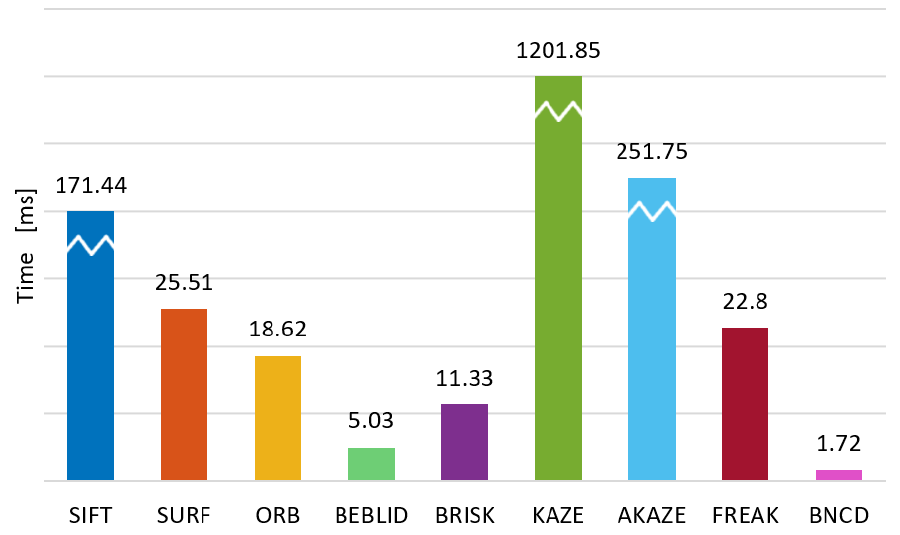
Figure 11. Time consumption of BNCD and advanced algorithms to calculate 500 descriptors.